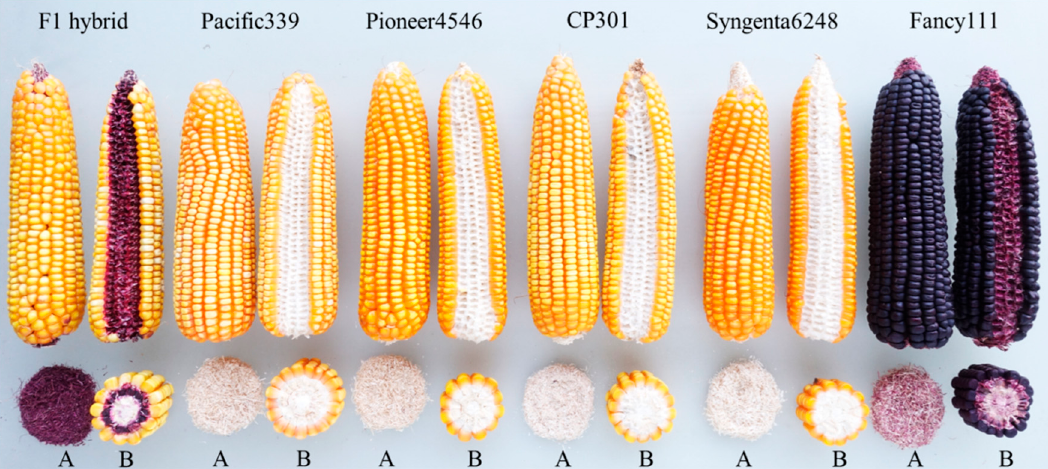
Figure 1. F1 hybrid (Takfa3 × KKU–PFC5) and control cultivars showing color of ground husk (A), cross section of ear (B) and kernel.